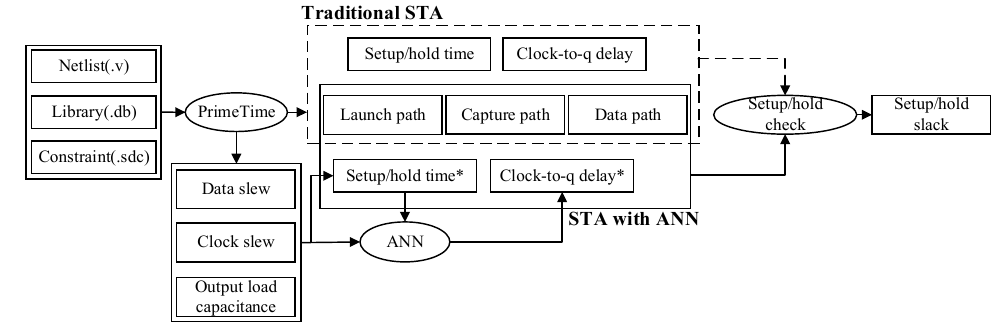
Figure 9. STA flow integrated with ANN ‐ based interdependent timing